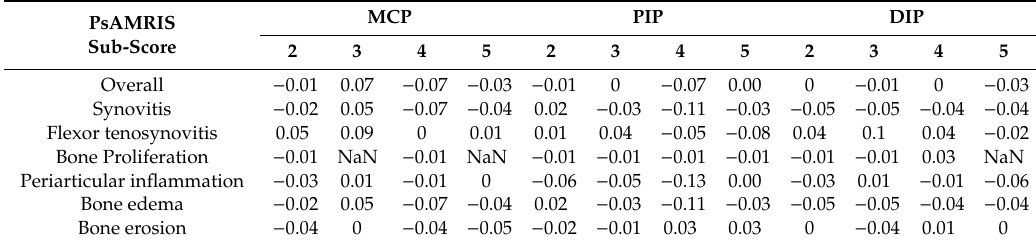
Table 2. Changes between T0 and T1 for the overall psoriatic arthritis resonance imaging score (PsAMRIS) and its sub-scores assessed by standardized response means (SRM) (PIP) and distal interphalangeal (DIP) joints of digits 2–5 in a clinical cohort of PsA patients. NaN—not available due to absence of the feature in the study population.